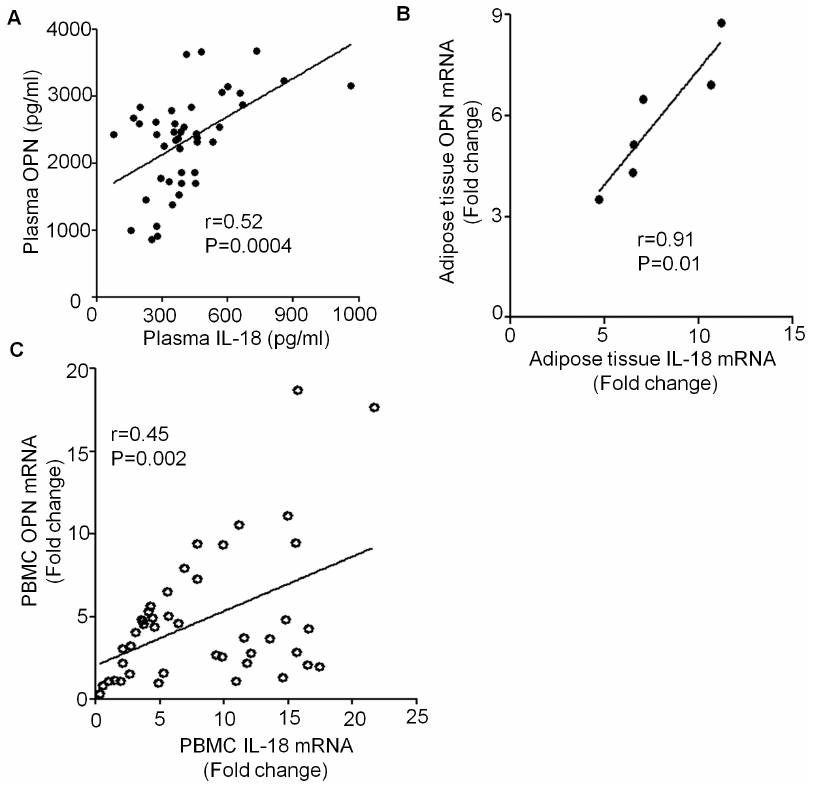
Figure 4. Linear regression between OPN and IL-18. Plasma OPN and IL-18 levels were determined by ELISA There was a statistical significant linear regression between OPN and IL-18 (r=0.52, P=0.0004, n=44) in obese and overweight individuals which were free from overweight/obesity induced major complications (A). A strong association of OPN mRNA (Fold change) with IL-18 mRNA was observed in adipose tissue (r=0.91, P=0.01: (B). Fold change expression of OPN and IL-18 mRNA in PBMCs of 44 overweight and obese individuals was correlated with each other (r=0.45, P=0.0018) (C).